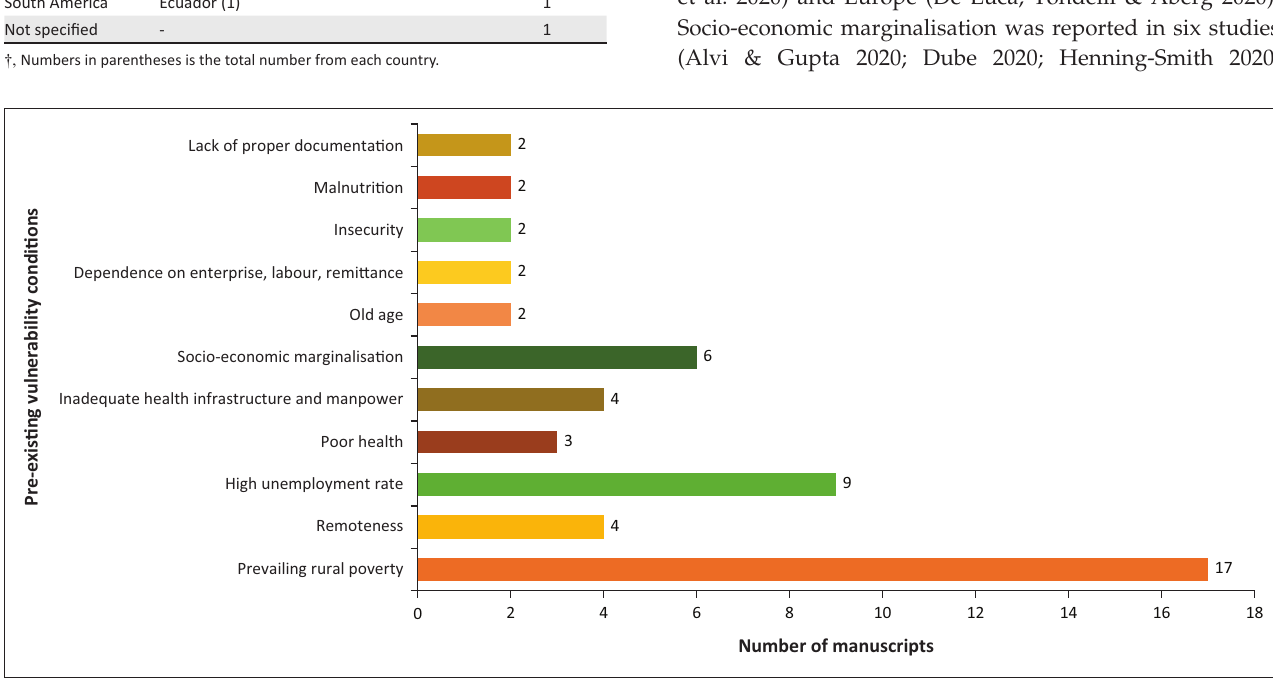
FIGURE 2: Pre-existing vulnerability conditions that worsened the impact of the COVID-19 pandemic.